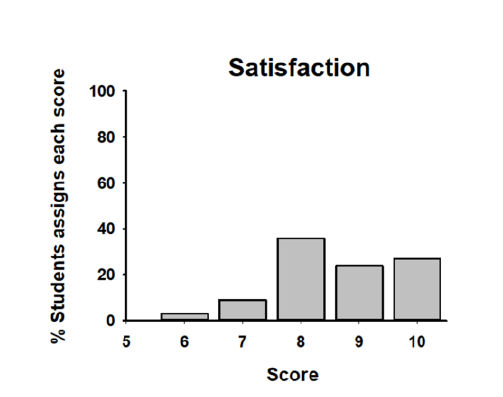
Figure 3. Percentage of students by level of satisfaction with the intervention (score 0: lowest satisfaction, score 10: highest satisfaction). Students showed scores above 6 in their level of satisfaction with the